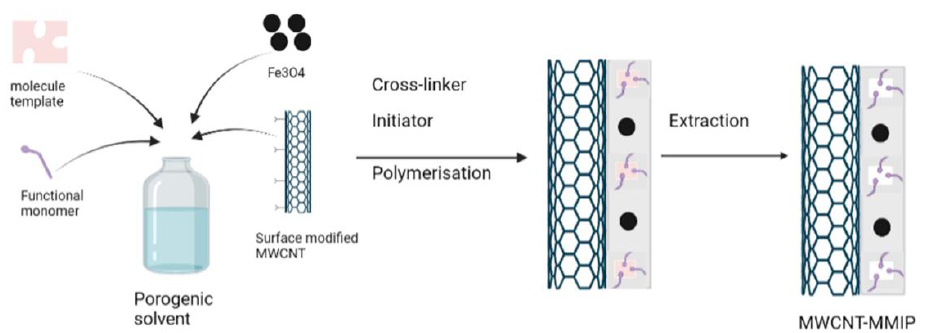
Figure 2. Scheme of synthesis of multiwalled carbon nanotubes based magnetic molecularly im- printed polymer (MWCNT-MMIPs).